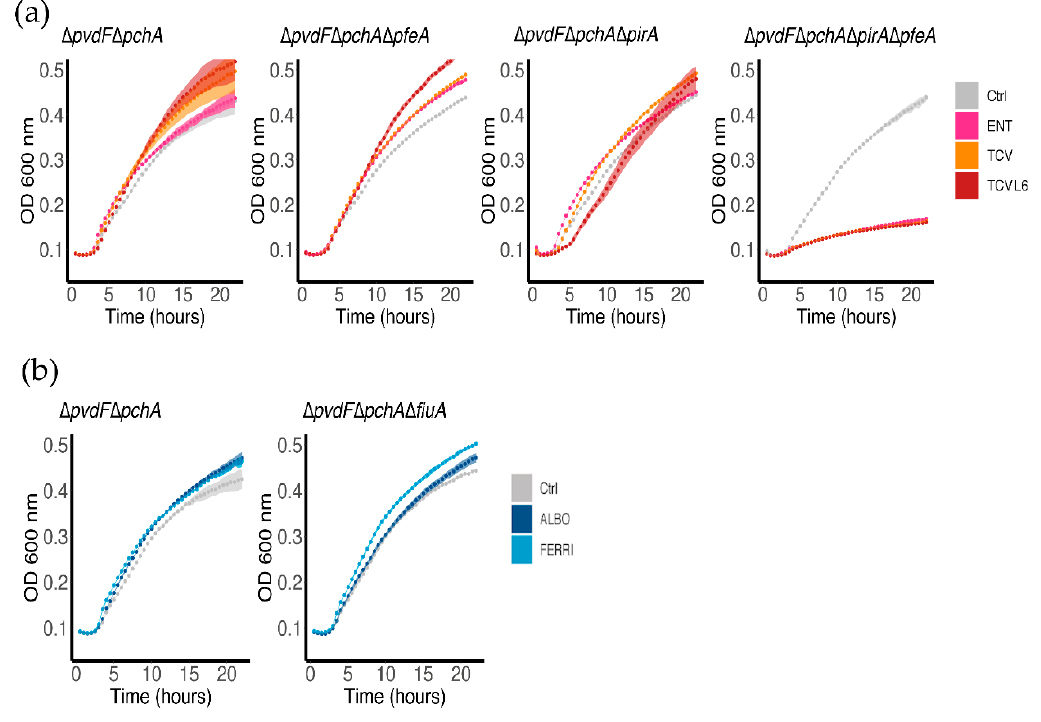
Figure 4. Bacterial growth in the presence of ENT, TCV, TCVL6, FERRI, or ALBO. Various strains ( ∆ pvdF ∆ pchA and its corresponding pfeA , pirA and fiuA deletion mutants) were grown in iron-restricted CAA medium, with or without 10 µ M ENT, TCVor TCVL6 ( a ), or FERRI or ALBO ( b ) at 37 ◦ C. For the Ctrl (control) only, the solvent (DMSO) used to solubilize the conjugates has been added to the cells. The growth curves are the mean of three independent biological triplicates.